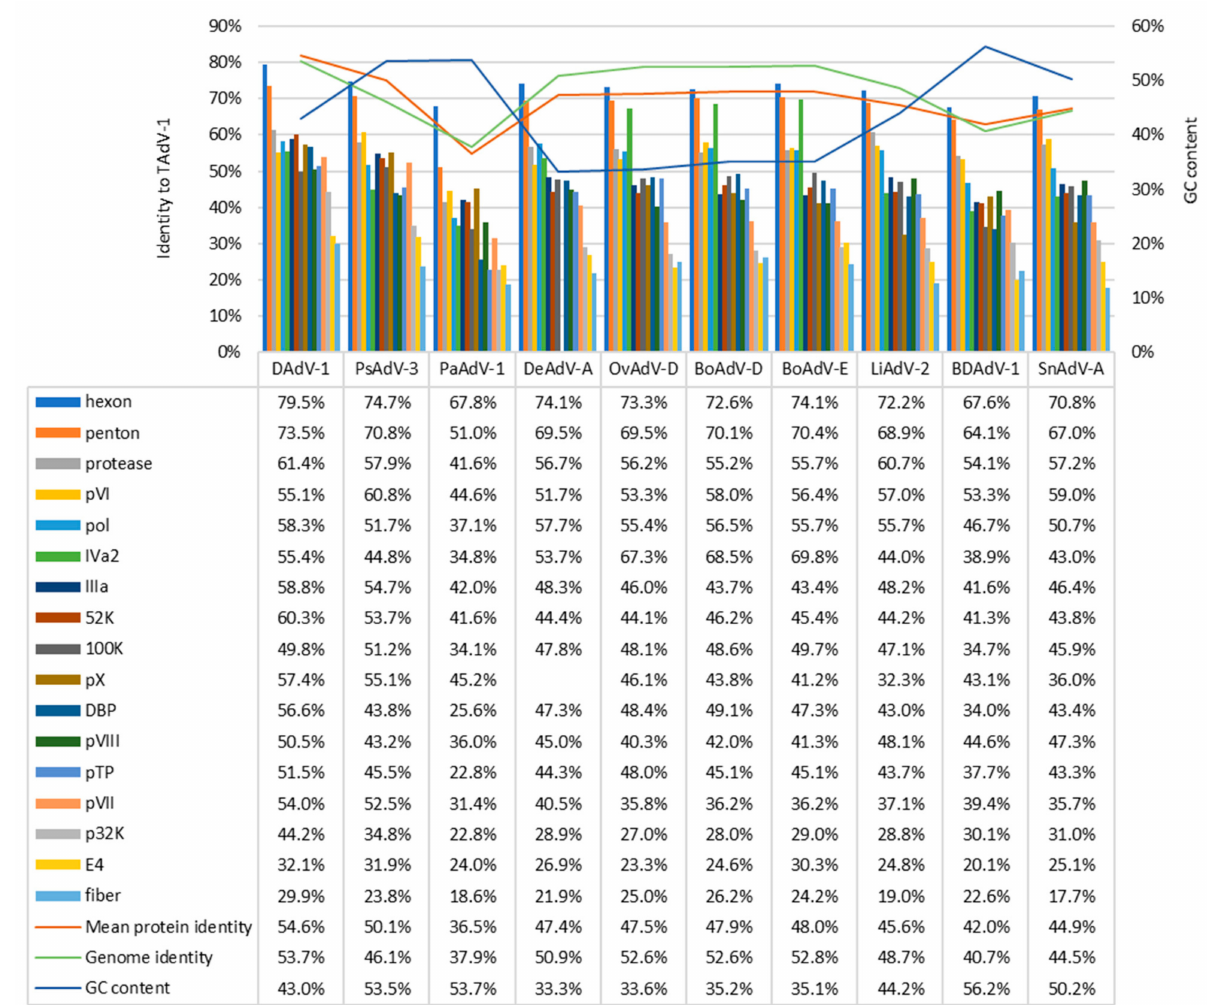
Figure 2. Comparison of TeAdV-1 genome with genomes of other members of Atadenovirus genus. Colored bars represent the degree of pairwise identity of specific proteins conservative within Adenoviridae family and Atadenovirus genus, colored lines represent mean protein and genomic sequence identity across all genes as well as mean GC